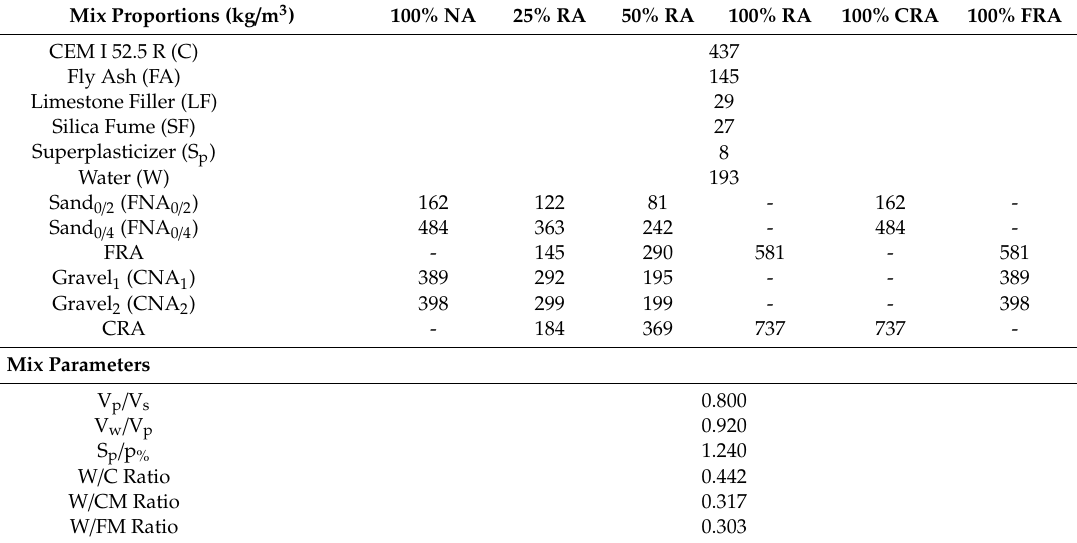
Table 3. Mix proportions and basic properties of the self-compacting concrete (SCC)